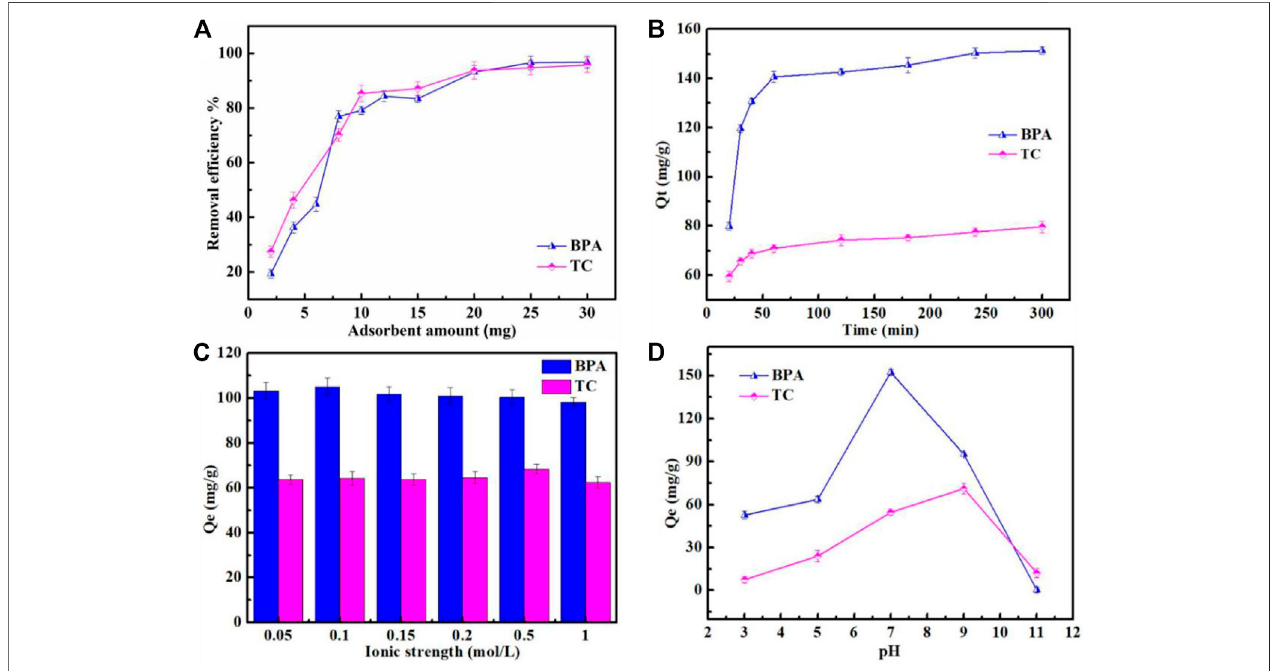
FIGURE 5 | (A) in fl uence of adsorbent amounts on BPA and TC; (B) in fl uence of time on BPA and TC; and (C) in fl uence of ionic strength on BPA and TC; (D) In fl uence of pH on BPA and TC.